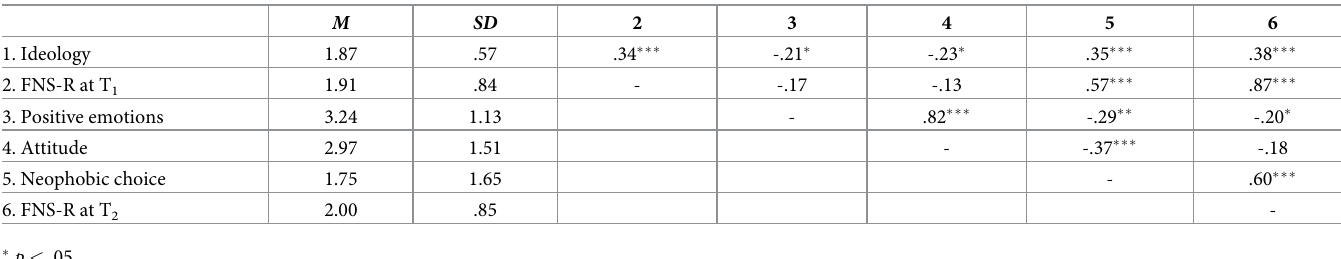
Table 6. Descriptives and correlations for Study 4 measures.